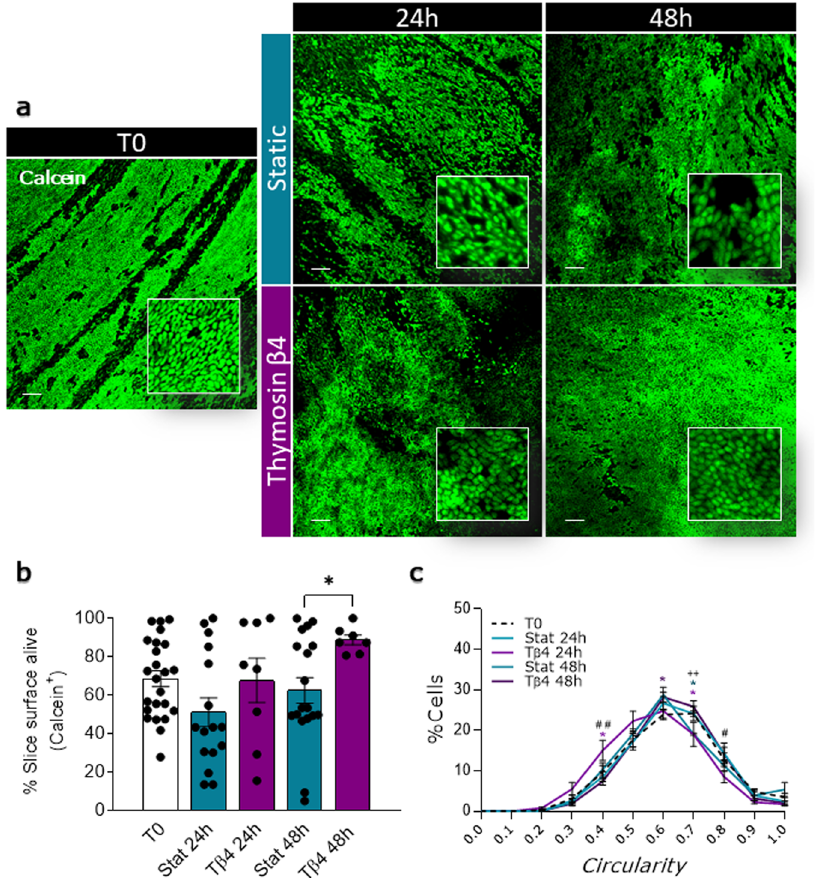
Fig. 7 T β 4 treatment alters epicardial cell viability and shape. Surface viability in freshly cut slices (T0), after 24 and 48 h of control static (Stat) culture and thymosin β 4 (T β 4) treatment ( a , b ). Representative confocal images ( a ) and quanti fi cation ( b ) indicates an increase in the percentage of live area upon T β 4 treatment at 48 h. N of pigs = 4 – 14, number of slices displayed in the graph. Epicardial cells circularity distribution ( c ). N of pigs = 3 – 5, number of slices: T0 = 8, Stat 24 h = 5, T β 4 24 h = 5, Stat 48 h = 5, T β 4 48 h = 9. All graphs display data as mean ± SEM. * p ≤ 0.05 vs T0, # p ≤ 0.05 Stat 24 h vs. T β 4 24 h, ## p ≤ 0.001 Stat 24 h vs. T β 4 24 h. ++ p ≤ 0.001 Stat 48 h vs. T β 4 48 h. Scale bar, 100